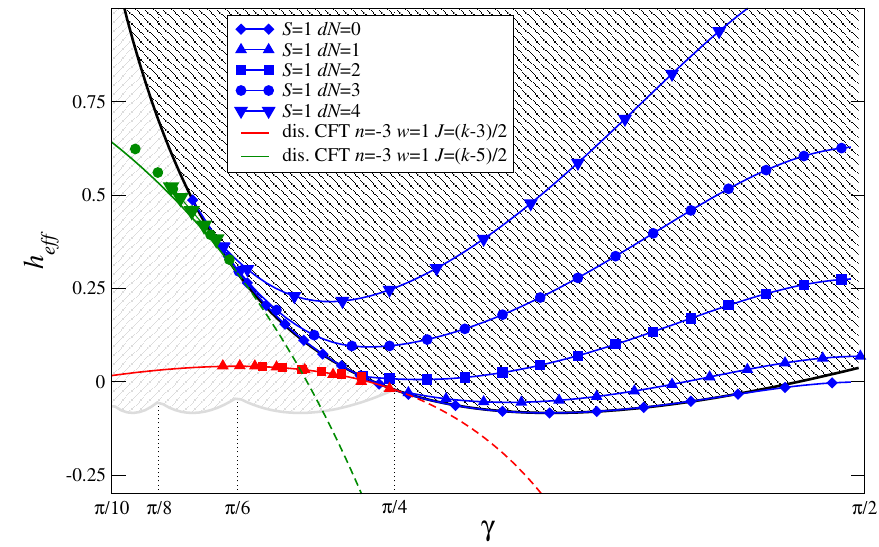
Figure 12 . Effective scaling dimensions vs. anisotropy γ for the self-dual model, α = π/ 2 , of size L = 40 , 41 derived for the lowest states in the S = 1 sector, showing the transmutations of continuous states into discrete ones. The black shaded area represents the continuum of levels starting at the spin- S GS = 1 ground state. Grey shading indicates the continua in the spin S GS > 1 sectors, which overlap with each other and the spin- S GS = 1 one. The lower edge of the continua corresponds to c eff (6.7) up to the factor of − 24 . Blue symbols denote the effective scaling dimensions obtained from finite size data (5.19) corresponding to weights from the continuous part with S = 1 of the CFT spectrum given in terms of root configurations (5.1) with different dN . Red and green symbols depict the continuation of the corresponding states (same symbol shape) to anisotropies where the Bethe root patterns change to (6.13) or (6.14) and the quasi-momentum s becomes imaginary. Red (green) solid lines are the effective scaling dimensions (6.9) of the primary fields from the discrete part of the CFT spectrum with n = − 3 , w = 1 and J = ( k − 3) / 2 ( ( k − 5) / 2 ) for k = π/γ . Dashed lines are their continuation to anisotropies γ > π/ (2 J +1) where the corresponding operators in the CFT become